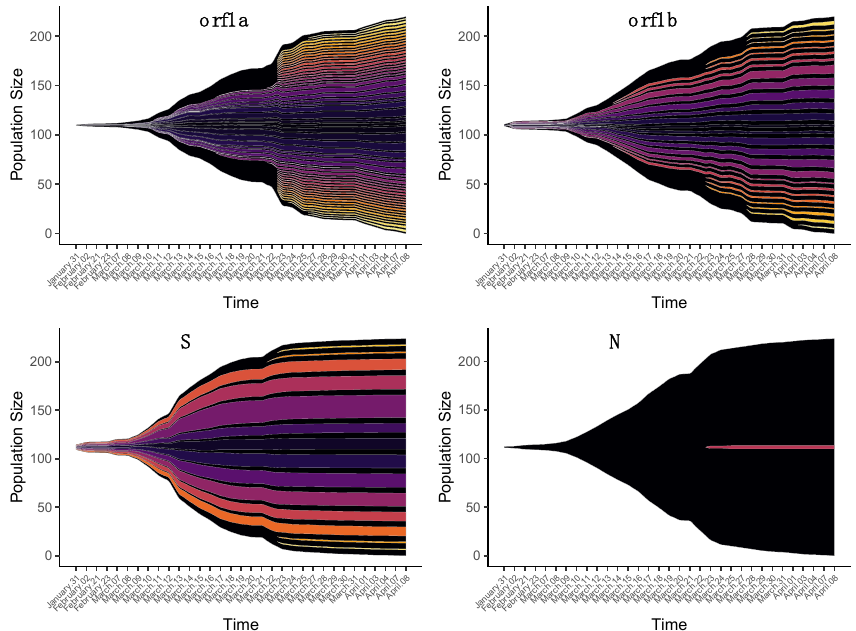
Figure 1. Temporal patterns of the diversity of nonsynonymous intra-host single-nucleotide variants (iSNVs) in four SARS-CoV-2 genes. Each fish plot represents the proportion of a specific nonsynonymous iSNV in the time interval covered by the samples. The dates indicate the days of sample collection.